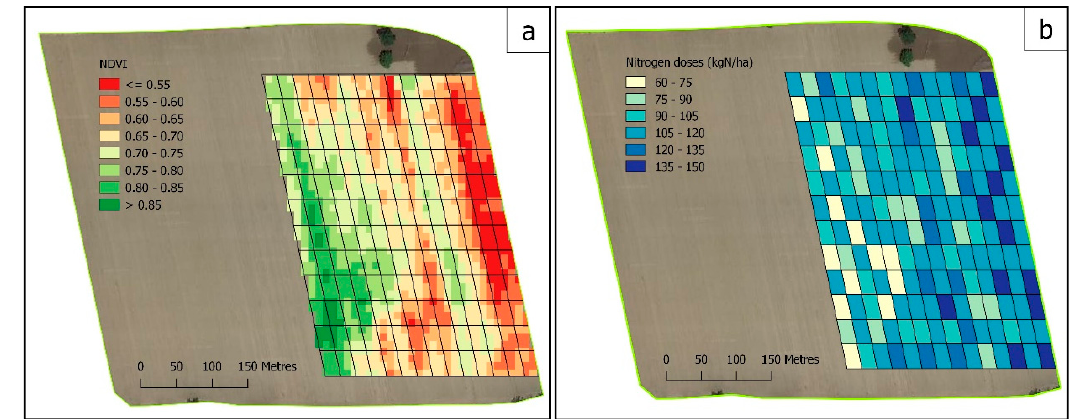
Figure 3. ( a ) NDVI calculated from Level 2A Sentinel-2 image collected on 22 March 2018; ( b ) 173 Prescription N map developed by integrating the three different experimental treatments. 174 Prescription N map developed by integrating the three di ff erent experimental